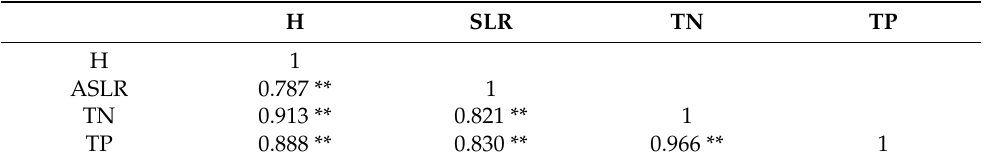
Table 5. Pearson correlation coefficients among annual runoff depth (AH), annual soil loss rate (ASLR), total nitrogen (TN), and total phosphorus (TP) losses. H SLR TN TP H 1 ASLR 0.787 ** 1 TN 0.913 ** 0.821 ** 1 TP 0.888 ** 0.830 ** 0.966 ** 1